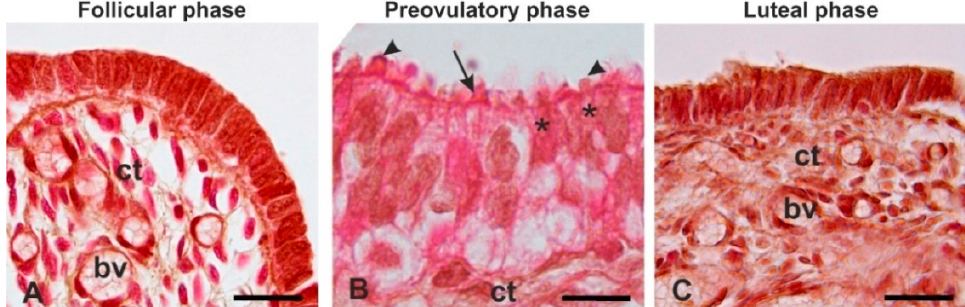
Figure 6. Representative light micrographs showing the morphological changes of the baboon Papio hamadryas oviductal epithelium during the follicular ( A ), pre-ovulatory ( B ), and luteal ( C ) phases. Note that the ciliated and non-ciliated cells were undistinguishable during the follicular and the luteal phase. Key: bv, blood vessel; ct, connective tissue; arrow, cilia; arrowhead, apical bleb; asterisk, non-ciliated cell. Hematoxylin-eosin staining. Scale bars = 10 μ m.